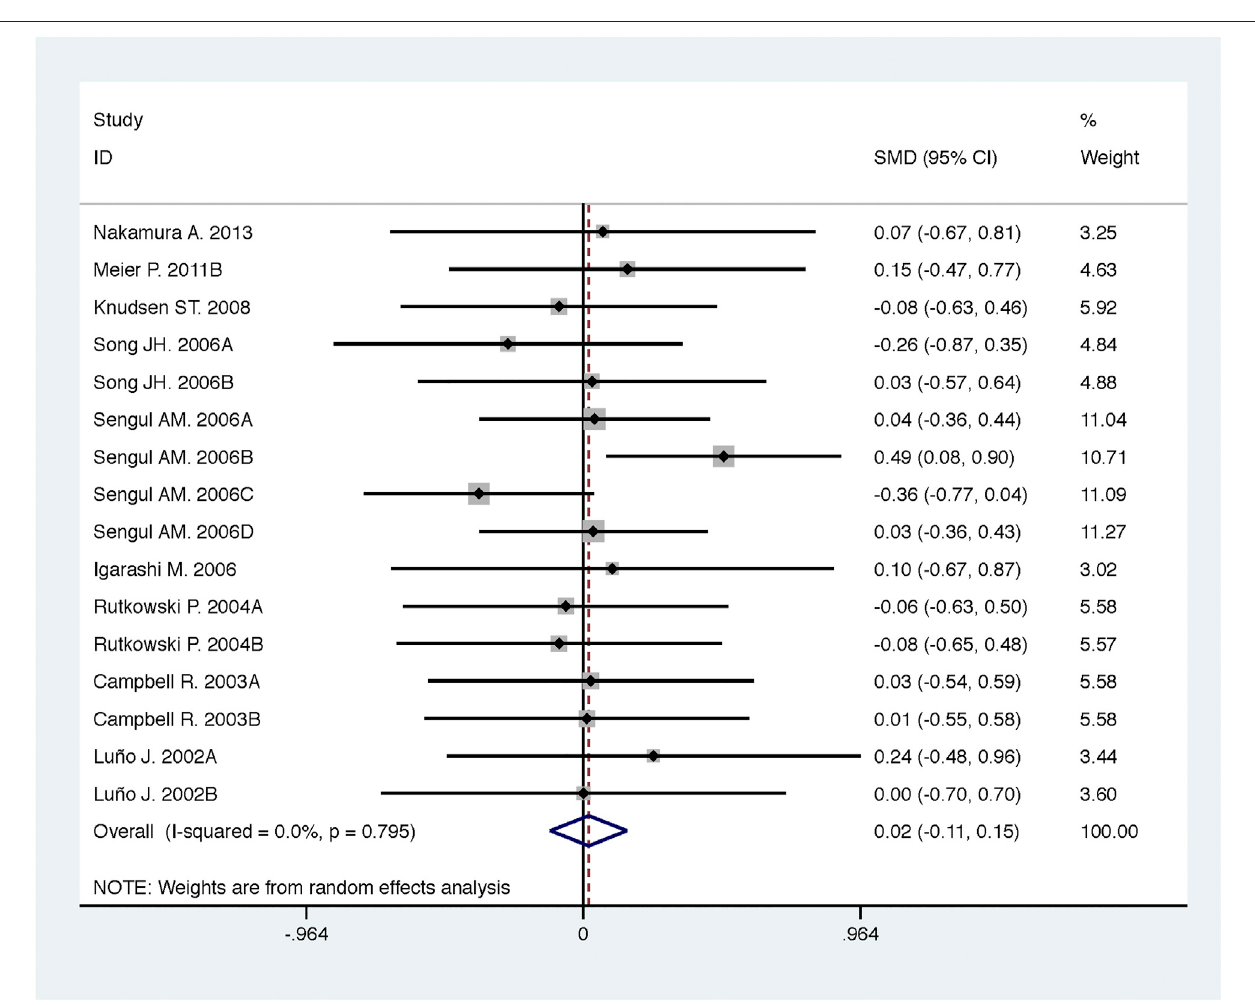
FIGURE 11 | Comparison of ACEI in combination with ARB vs. high-dose ACEI or ARB for glomerular fi ltration rate (mL/min or mL/min/1.73m 2 ).